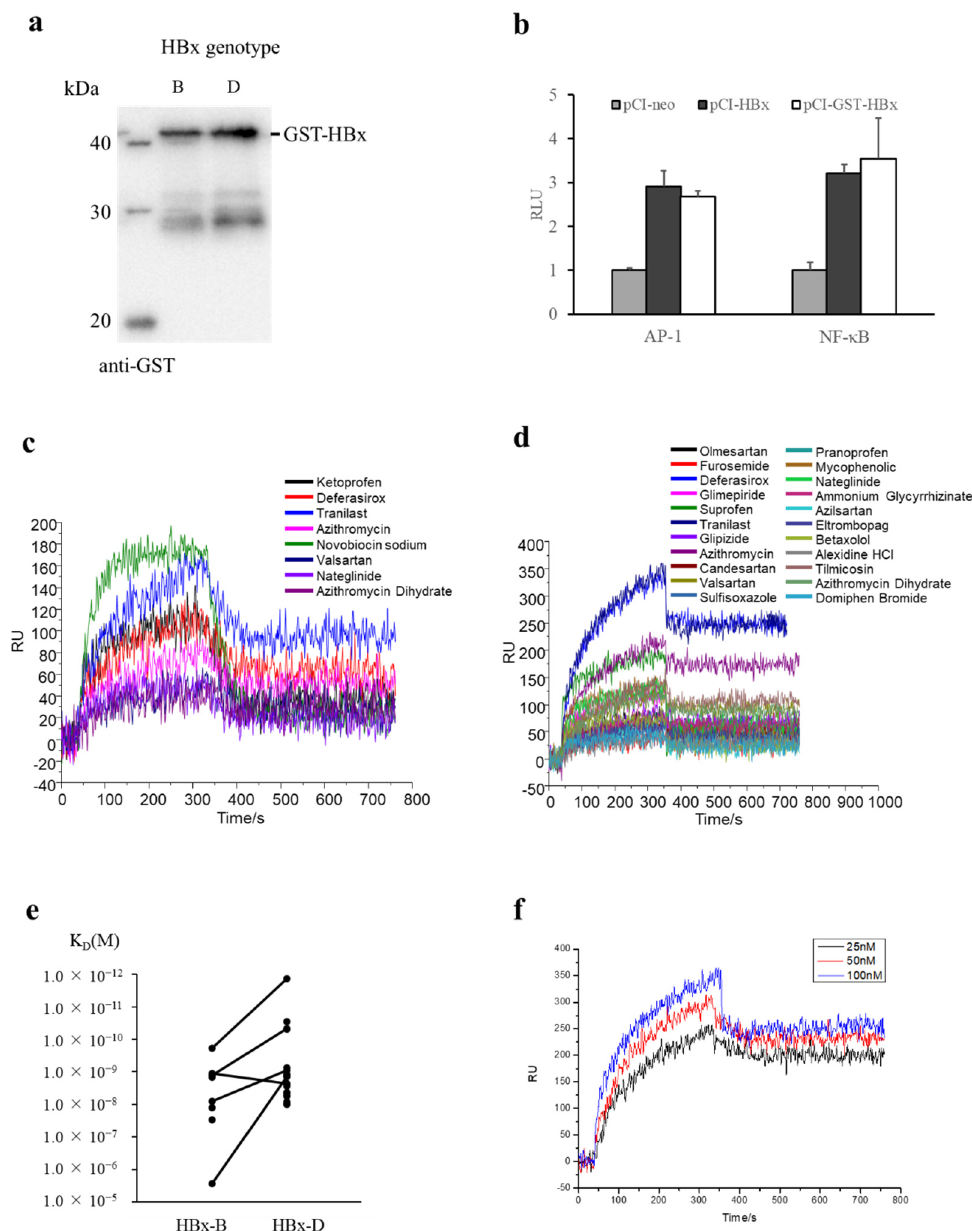
Figure 1. Screening of GST-HBx binding compounds. ( a ), Immunoblot of purified GST-HBx (genotype B) and GST-HBx (genotype D). ( b ), Transactivation function of GST-HBx. HeLa cells were